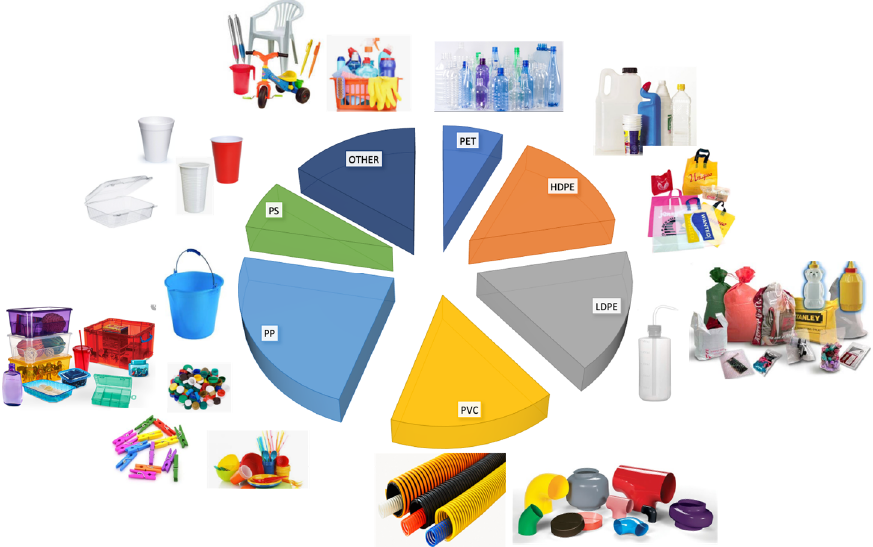
Figure 1. General distribution and application of plastics.